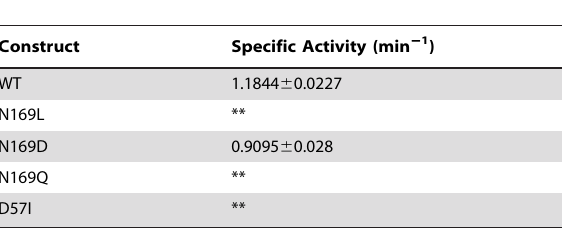
Table 2. GTPase Activity of YqeH